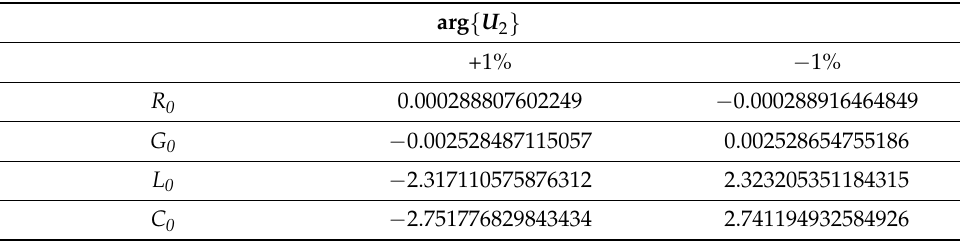
Table 9. Changes to the argument of the voltage U 2 .